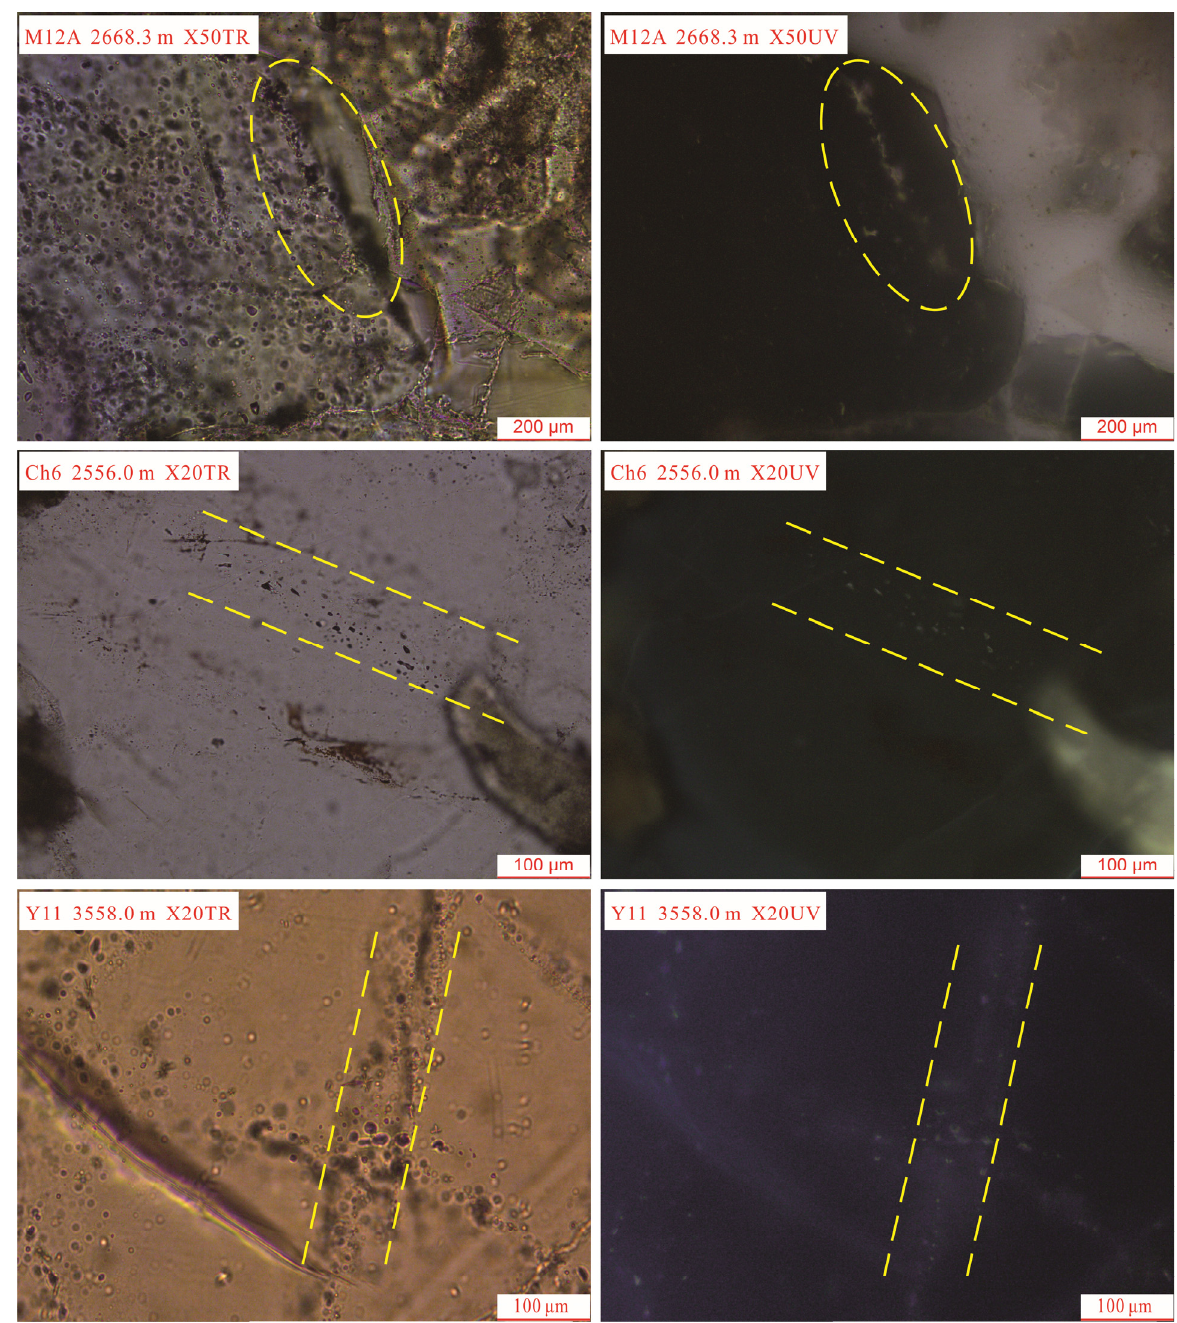
Figure 9. Characteristics of typical fluid inclusions under transmitted light (TR) and ultraviolet light (UV) observed at room temperature.